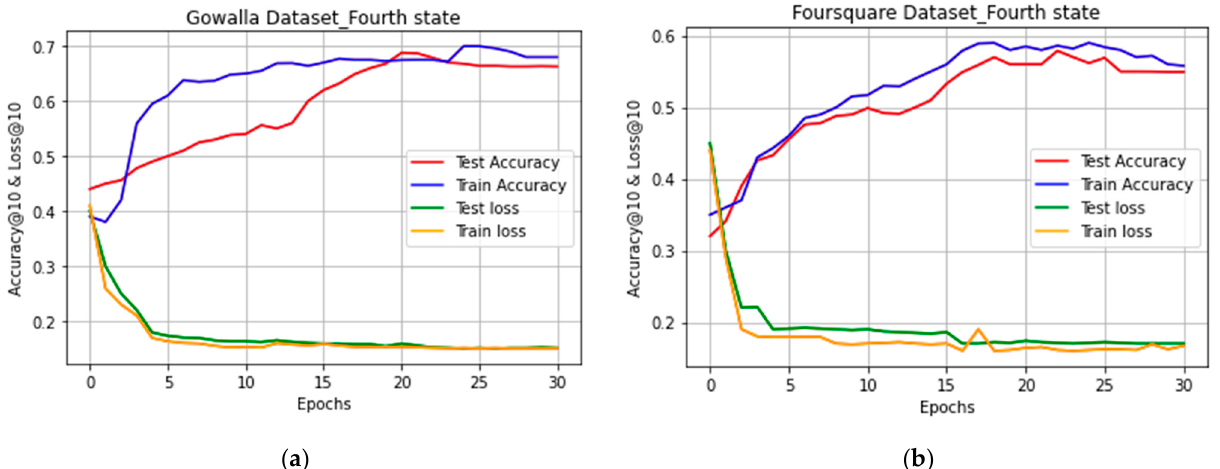
Figure 11. Training and testing accuracy @10 and loss @10 for two datasets vs. epochs in the fourth state of experiments. ( a ) Gowalla dataset; ( b ) foursquare dataset.